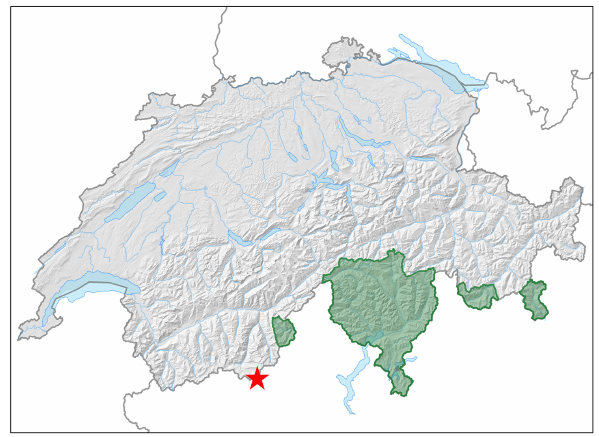
Figure 1. Map of Switzerland (MeteoSwiss, 2015); the drilling site at the Grenzgletscher (red star) and the area of the southern Swiss Alps (green) used to extract fire events are